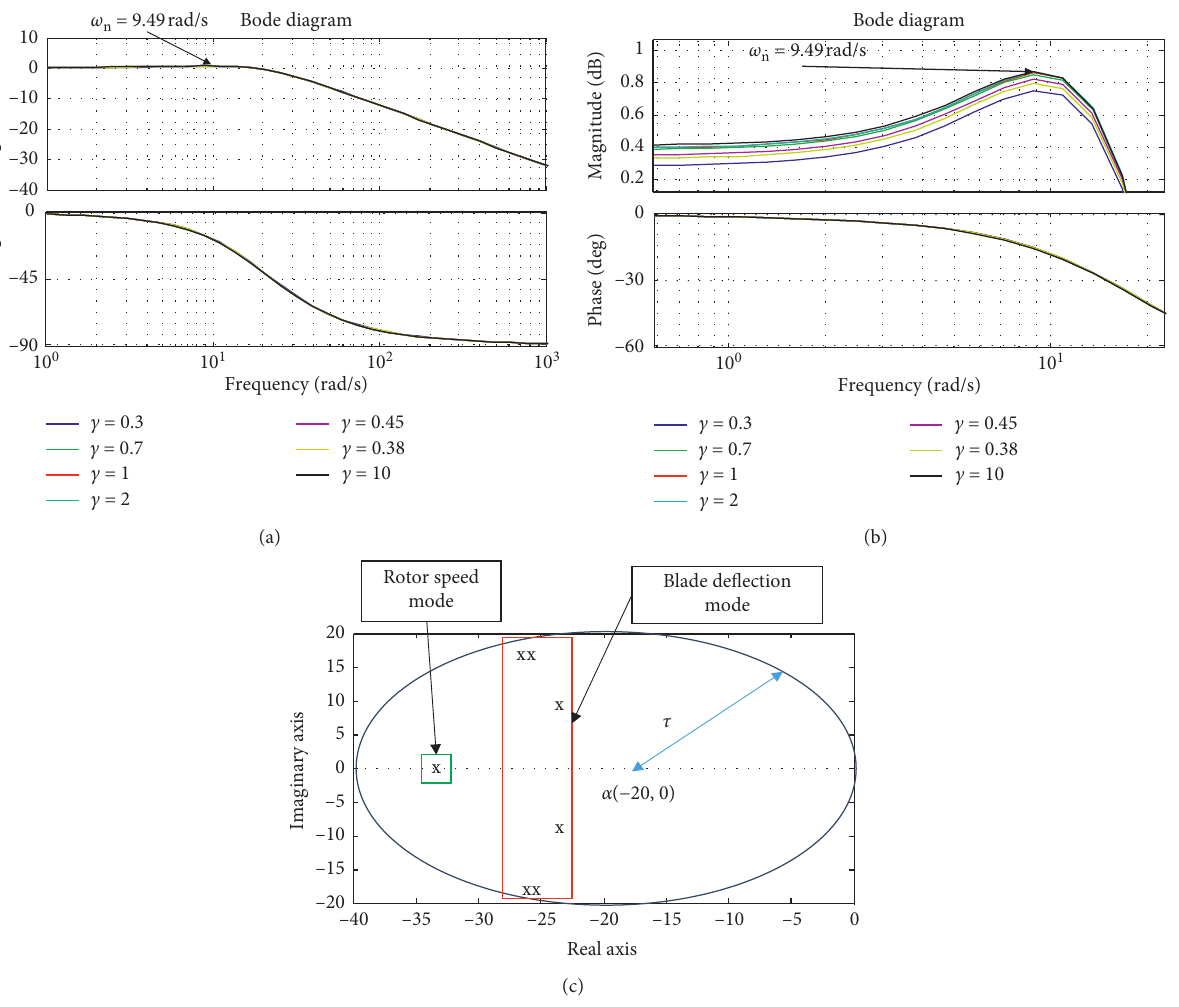
Figure 5: (a) Bode diagrams of the designed observer for different performance levels. (b) Zoom on the Bode diagrams of the designed observer for different performance levels. (c) The state observer pole placement for LMI region ( α , τ ) � (− 20 , 20 ) in the complex